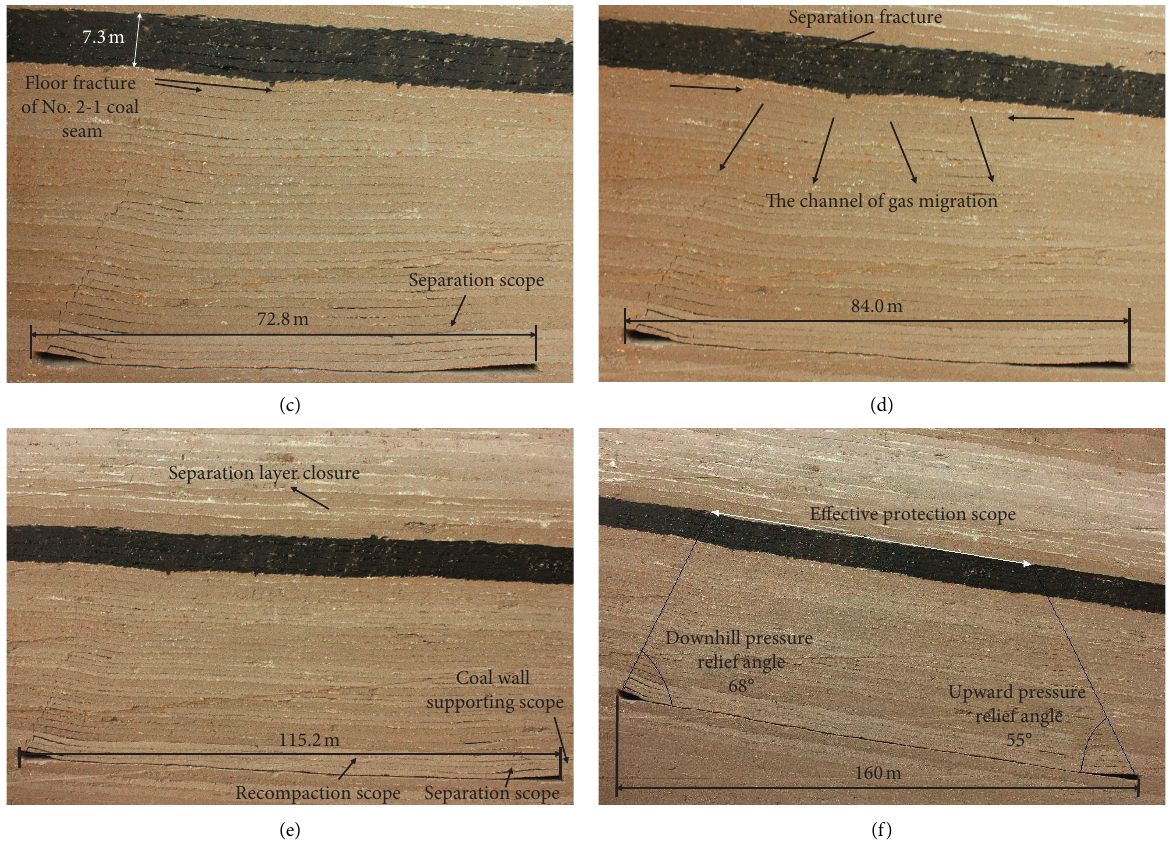
Figure 10: Fracture characteristics of strata while mining the rock-coal composite protective layer. (a) Working face is advanced to 32.4m; (b) working face is advanced to 48.5m; (c) working face is advanced to 72.8m; (d) working face is advanced to 84.0m; (e) working face is advanced to 115.2m; (f) working face is advanced to 160m.